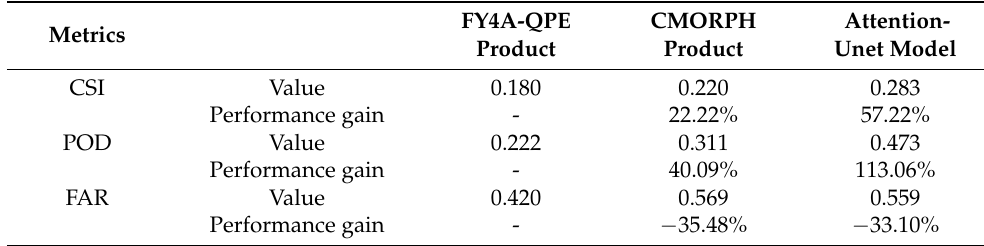
Table 4. Summary of precipitation identification performances over the verification